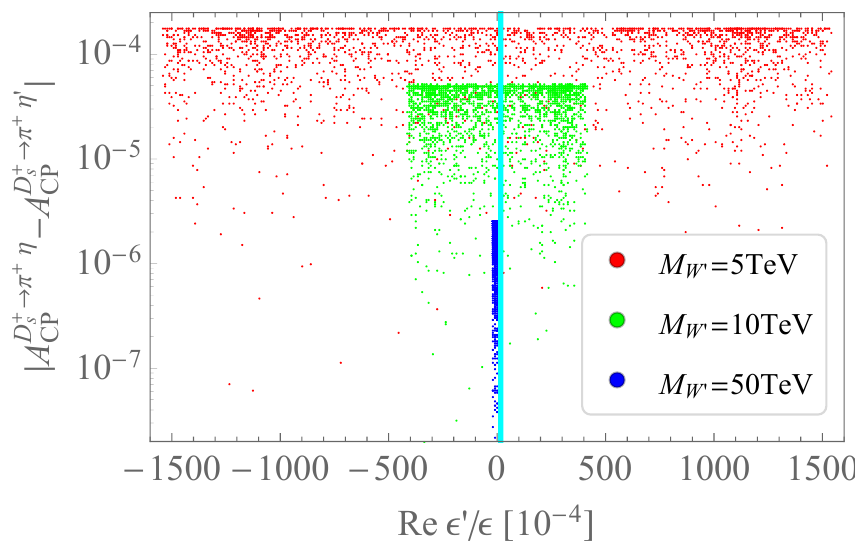
! (cid:25) + (cid:17) and D + ! (cid:25) + (cid:17) 0 , s s